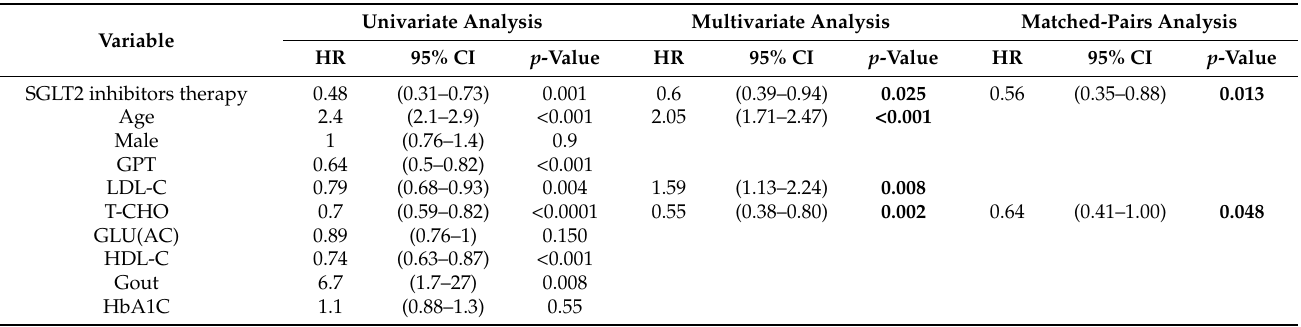
Table 3. Univariate and multivariate analyses of atrial fibrillation incidence in the study